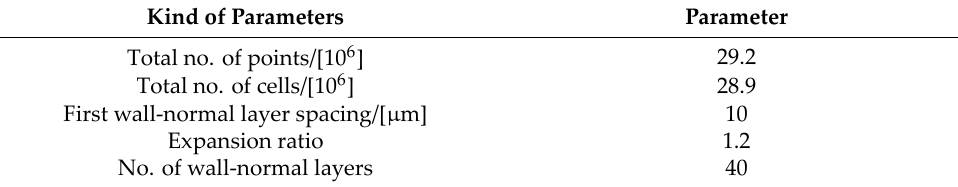
Table 3. CFD grid